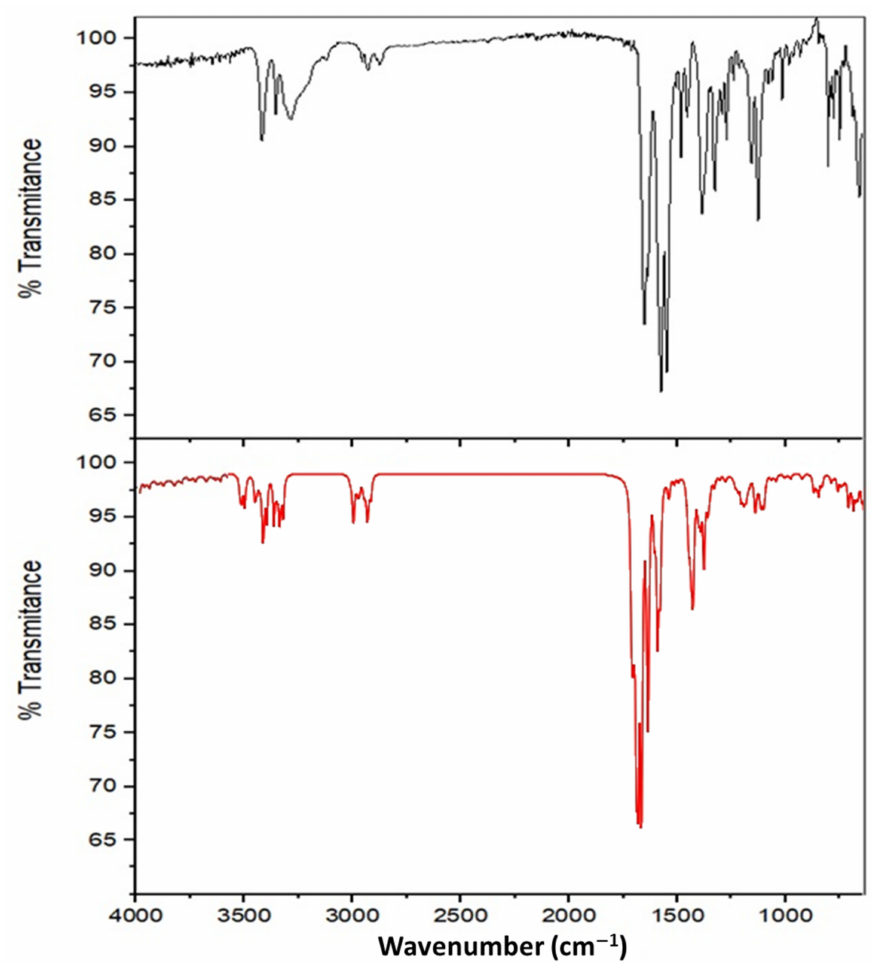
Figure 6. FTIR experimental spectrum of [Cu(Citr) 2 ] n in the region 4000–650 cm − 1 (black line) and FTIR calculated spectrum at the level of theory mPW1PW91/6-31G(d)-LANL2DZ and ECP=LANL2DZ (red